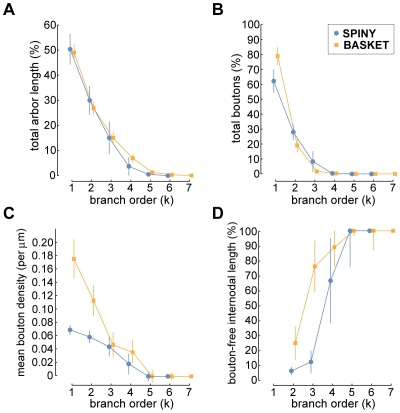
Axon length and number of boutons per branch order.For both basket and spiny cell axons, with increasing branch order there was a rapid decline in (A) percentage of total axon arbor length per arbor, (B) percentage of total boutons per arbor, and (C) mean bouton density (measured from ‘bouton-laden’ axonal sections only, so ignoring ‘bouton-free’ section length from the calculation – for distinction, see text), which was initially much higher from basket than spiny cell axons. Hence, the majority of axonal wire and boutons were found on first- and second-order branches. (D) Proportion of internodal axon length per branch order accounted for by ‘bouton-free’ sections increased with branch order with an offset between spiny and basket cell classes reaching 100% at fifth-order.